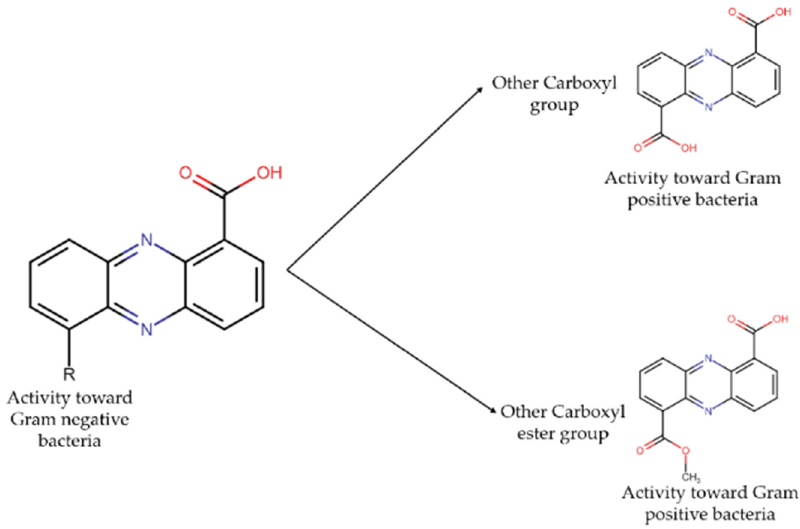
Figure 7. SAR of phenazine compound, modified from [27].